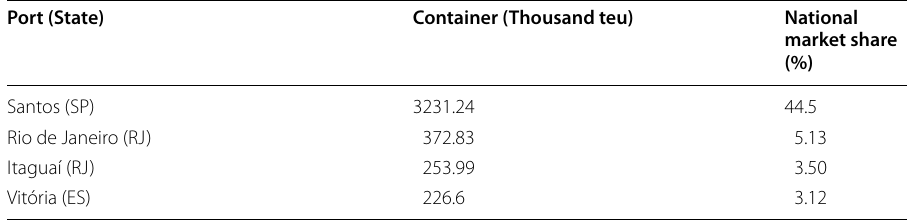
Table 1 Container handling in the Ports of Southeast Brazilian